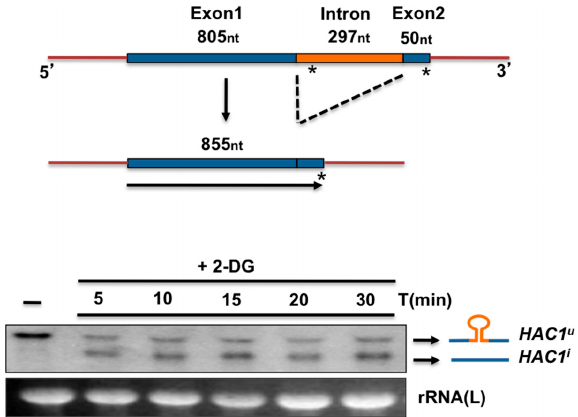
Figure 5. ( Top ) Diagram of the precursor and processed forms of K. lactis HAC1 RNA. Exon and intron sizes (nucleotides) were determined by sequence analysis. Size of the induced HAC1 ( HAC1 i ) includes the stop codon. ( Bottom ) Northern blot analysis of HAC1 processing. K. lactis cells were grown in YPD (1% yeast extract, 2% peptone, and 2% Glucose) until 0.5 OD 600 . Cells were treated with 20 mM 2-DOG for the indicated times. Total RNA was extracted with the conventional Trizol protocol. Boiled RNA was loaded in a 1% agarose gel, electrophoresed, and transferred to a nylon membrane. The RNA was probed with a fragment containing the first 500 nt of the HAC1 ORF labelled with 32 P and visualized in a phosphorimager. The large rRNA was used as a load